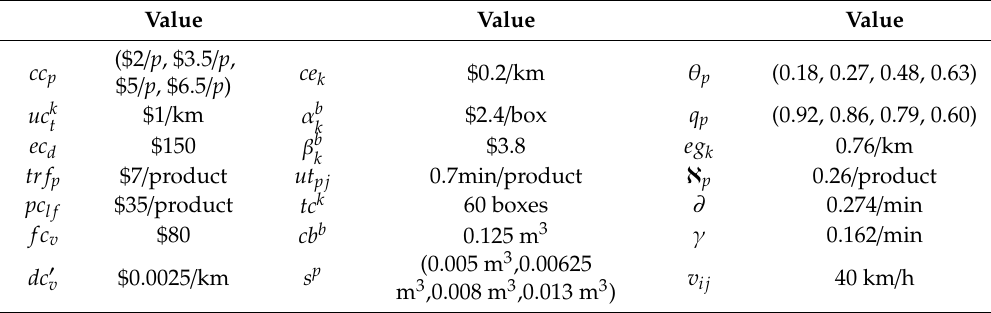
Table 8. Input values of model